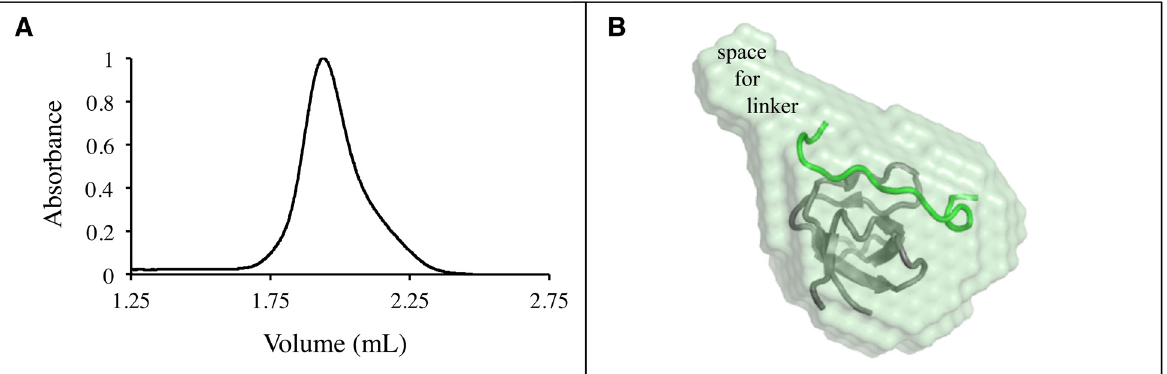
Fig 3. SAXS and gel filtration chromatography of HLL. (A) Gel filtration chromatogram of the HLL sample. Absorbances are reported at 205 nm and expressed as a fraction of the maximum change. (B) Molecular envelope is calculated for HLL. Inside the envelope is a cartoon representation of the AbpSH3-ArkA complex (pdb code 2rpn) and a label indicating an area to fit the linker that connects the C-terminus of the domain (grey) to the N-terminus of the peptide